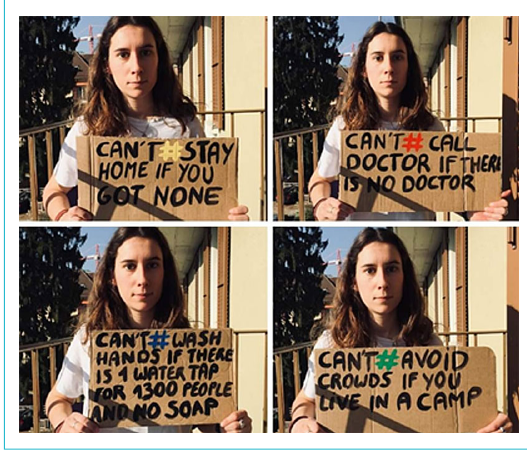
Figure 3: Swiss activist raising awareness on the difficulties to im- plement COVID-19 prevention measures in refugee camps (pic- tures provided by Céline de Richoufftz, reproduced with permis- sion).